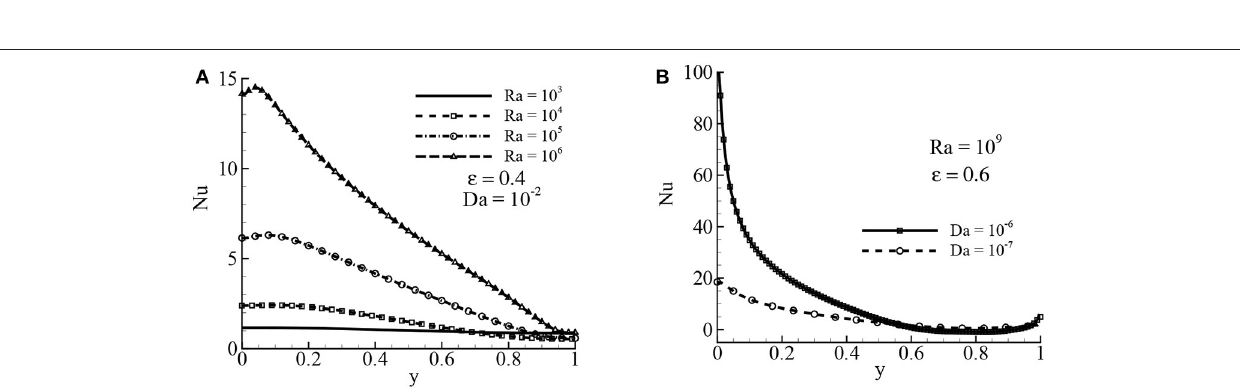
FIGURE 11 | Local Nusselt number Nu for (A) different Ra values while Da